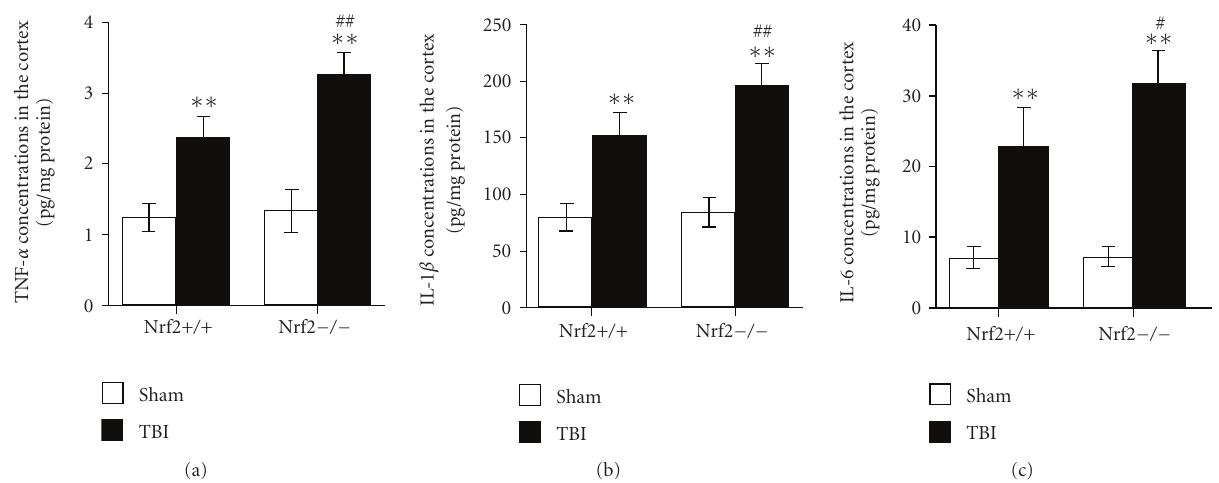
Figure 3: Concentrations of inflammatory cytokines in the cortex of sham and injured Nrf2 (+/+) and Nrf2 ( − / − ) mice. Concentrations of (a) TNF- α , (b) IL-1 β , and (c) IL-6 were determined by ELISA in the brain samples of Nrf2 (+/+) and Nrf2 ( − / − ) mice 24 hours after TBI. The figure indicates that concentrations of TNF- α , IL-1 β , and IL-6 in brain were significantly increased after TBI and were greater in Nrf2 ( − / − ) mice than in Nrf2 (+/+) mice. Data represents mean ± SEM ( n = 5 per group). ∗∗ P < . 01 versus sham control of the same genotype. # P < . 05 and ## P < . 01 versus injured wild-type